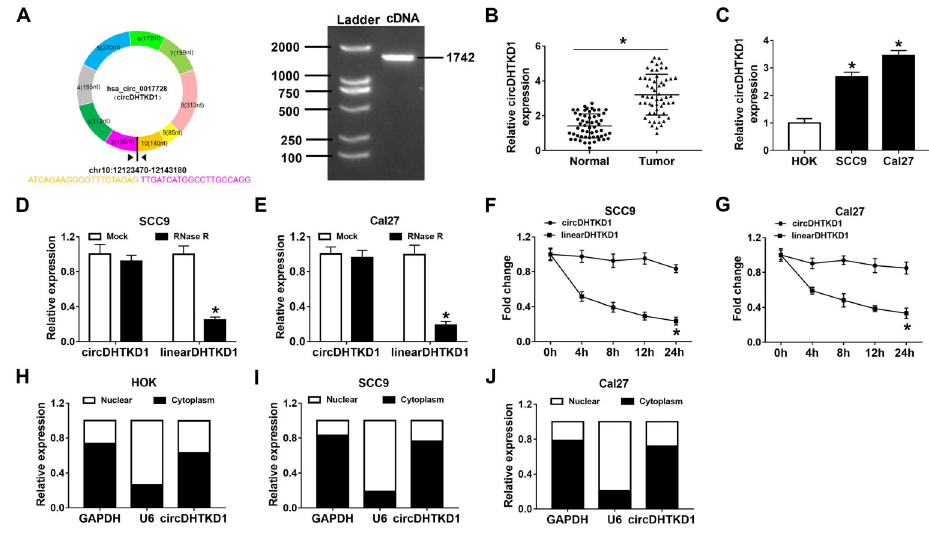
Figure 1. Identi fi cation of upregulated circDHTKD1 in oral squamous cell carcinoma (OSCC) tissues and cells. A , Genetic information of circDHTKD1 and the analysis of circDHTKD1 length by conventional PCR. B and C , qRT-PCR was applied for expression of circDHTKD1 in OSCC/normal tissues and OSCC (SCC9 and Cal27) cells/HOK cells. Three biological and three technical replicates were performed. circDHTKD1 and linear DHTKD1 levels were determined using qRT-PCR after RNase R treatment for total RNA ( D and E ) and actinomycin D treatment for OSCC cells ( F and G ). Three biological and three technical replicates were performed. H – J , The detection of circDHTKD1, GAPDH, and U6 was carried out via qRT-PCR in nuclear and cytoplasmic fractions of HOK cells and OSCC cells. Three biological and three technical replicates were performed. Data are reported as means ± SD. *P o 0.05 (Student ’ s t